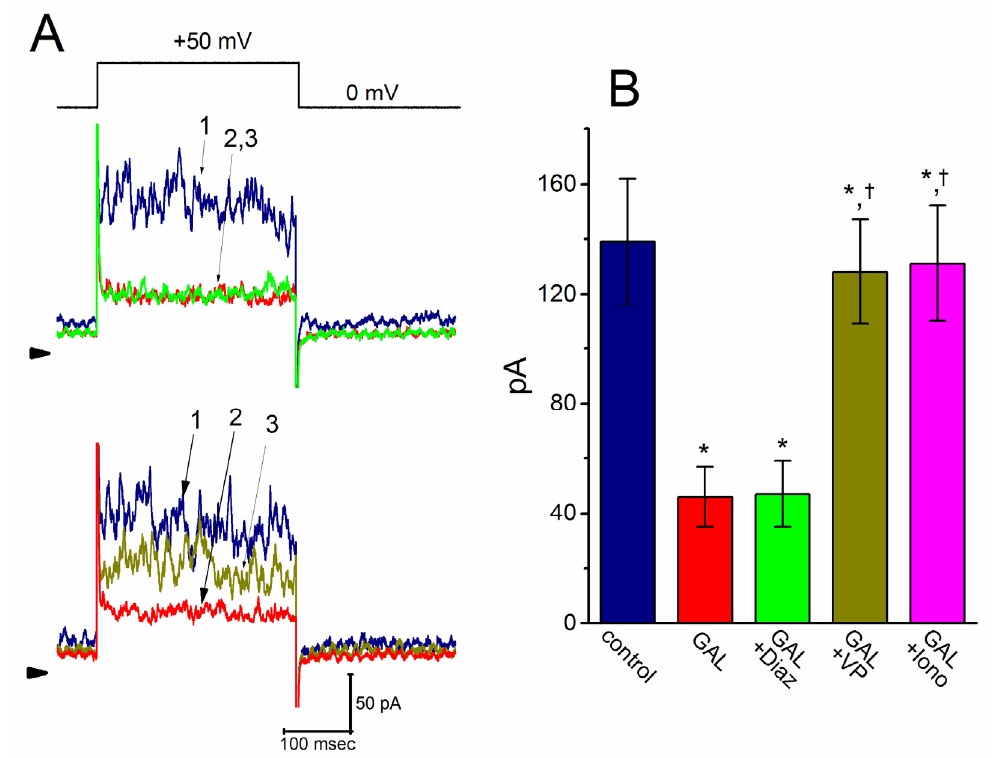
Figure 2. ( A ) Comparisons of e ff ects of GAL-021, GAL-021 plus diazoxide, GAL-021 plus verteporfin, and GAL-021 plus ionomycin on IK(Ca) amplitude recorded from GH3 cells. During these measurements, current amplitude was taken at the end of 300 ms voltage step from a holding potential of 0 mV to + 50 mV. Current traces labeled 1 in ( A ) are controls, and those labeled 2 were taken during cell exposure to 3 µ M GAL-021, while those labeled 3 were obtained in the presence of 3 µ M GAL-021 plus 10 µ M diazoxide (upper panel), or in the presence of 3 µ M GAL-021 plus 10 µ M verteporfin (lower panel). The uppermost part indicates the voltage protocol applied, arrowhead in each panel shows the zero-current level, and calibration mark in the right lower part in (A) applies to all current traces. ( B ) Summary bar graph showing e ff ects of GAL-021, GAL-021 plus diazoxide, GAL-021 plus verteporfin, and GAL-021 plus ionomycin on IK(Ca) amplitude. Current amplitudes were recorded and then measured at the end of each depolarizing pulse from 0 to + 50 mV, and each bar represents the mean ± SEM ( n = 7 to 9). *, Significantly di ff erent from control ( p < 0.05) and † , significantly di ff erent from GAL (3 µ M) alone group ( p < 0.05). GAL, 3 µ M GAL-021; Diaz, 10 µ M diazoxide; VP, 10 µ M verteporfin; and Iono, 10 µ M ionomycin.